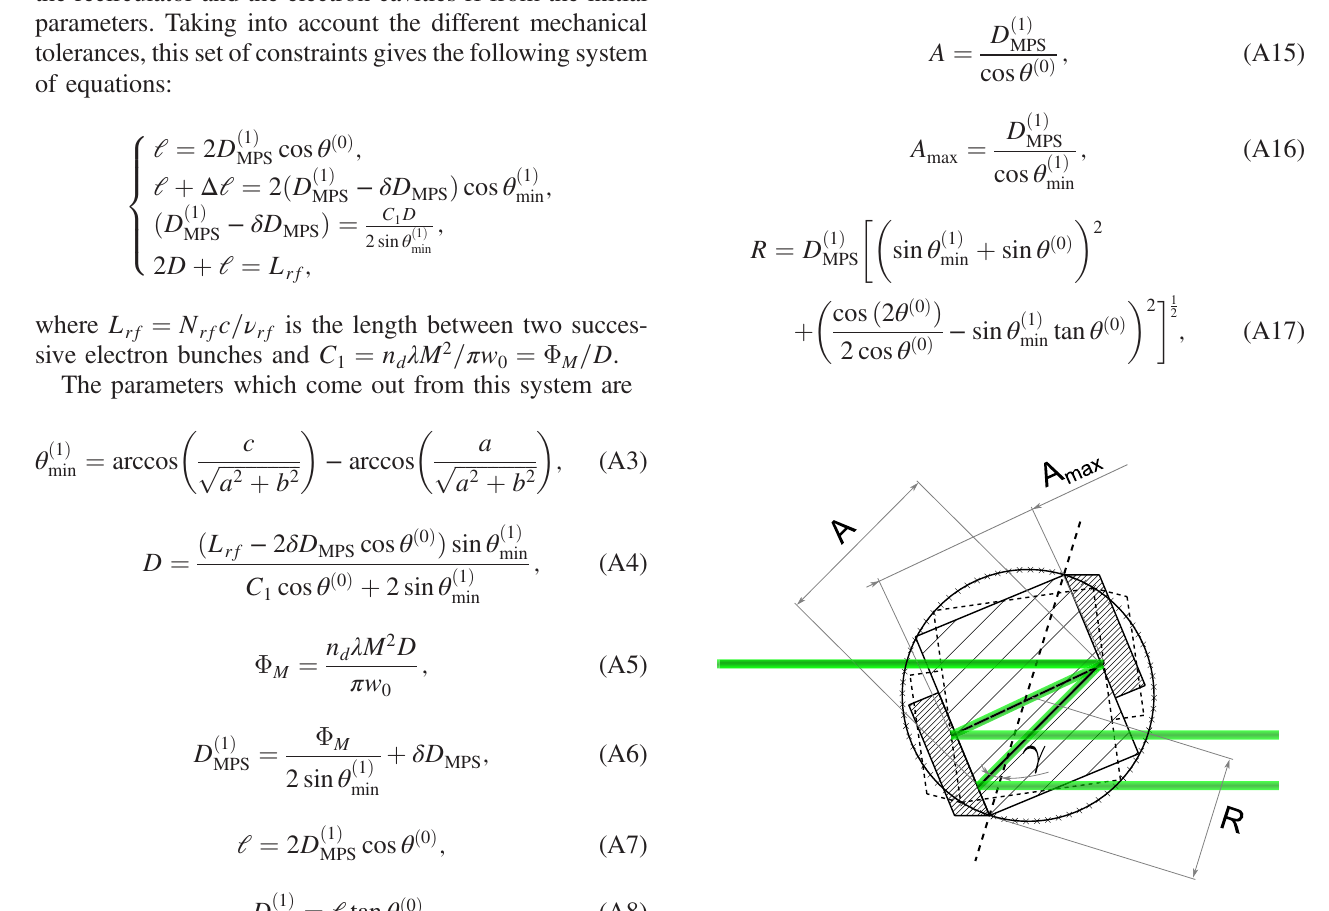
FIG. 20. Scheme of stroke calculation